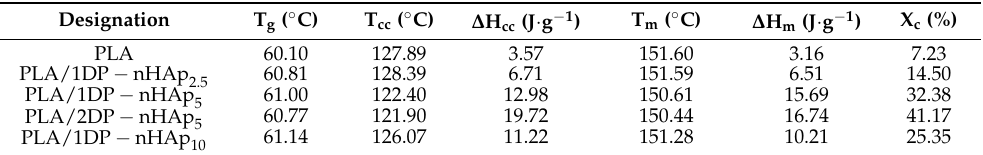
Table 3. Thermal characteristics of PLA and PLA/nHAp composite films with nHAp from different preparation steps and 1DP-nHAp at various contents.